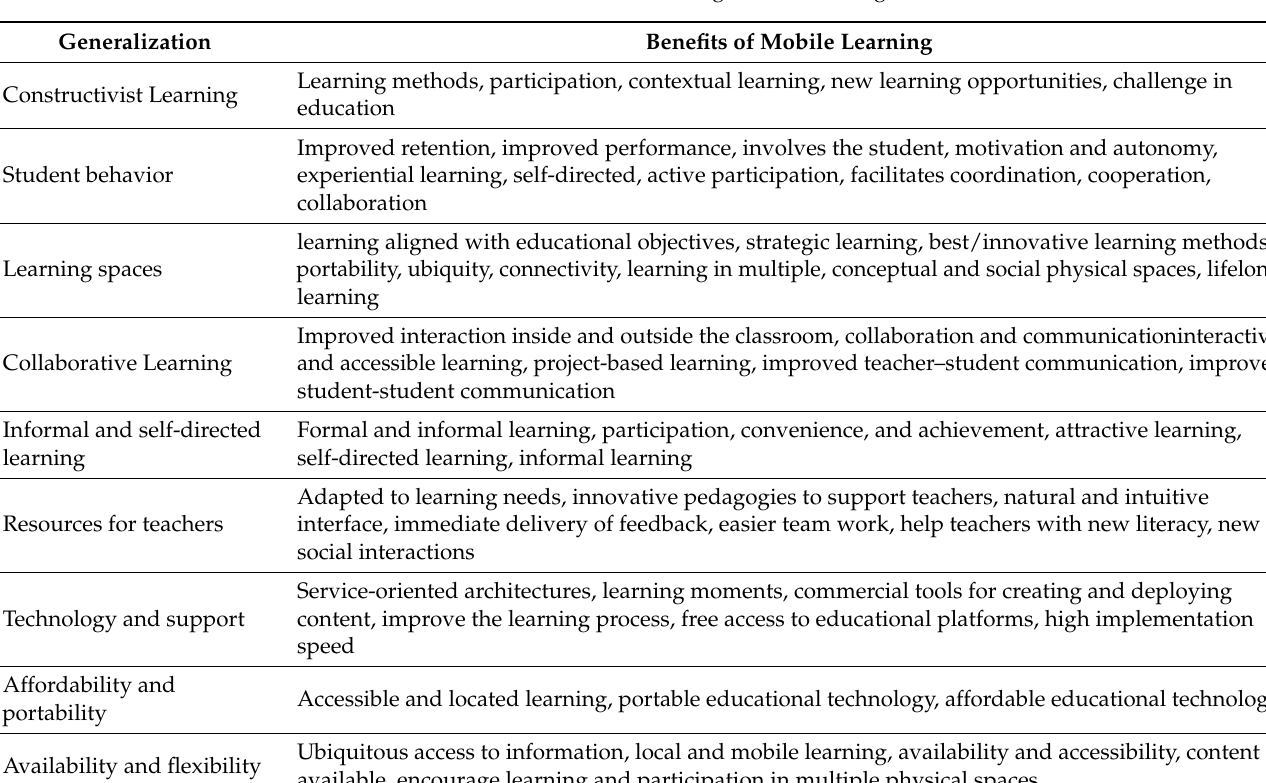
Table 3. Generalization of the benefits of using mobile learning in